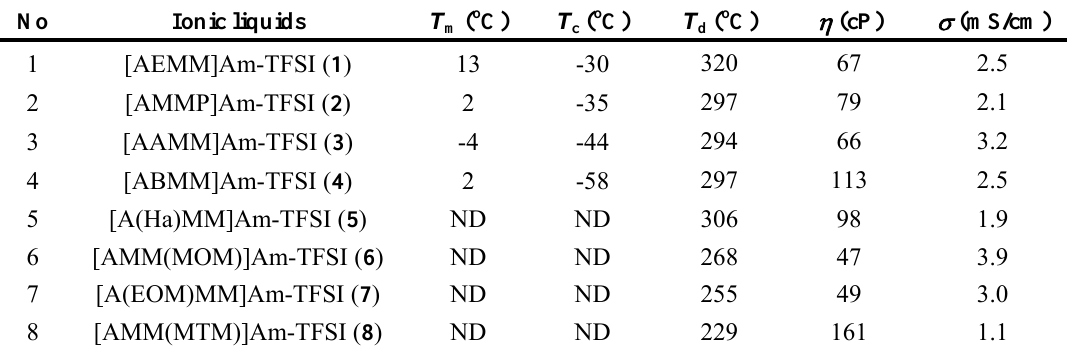
Table 1. Physicochemical properties of the ILs prepared.